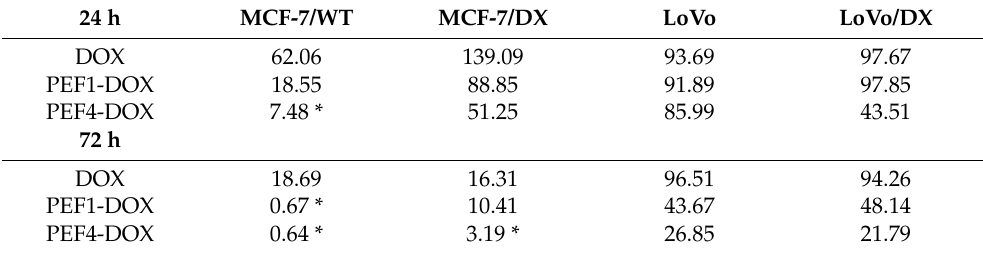
Table 1. IC50 values that reduce cell proliferation by 50% calculated and represented as micromolar concentration for DOX and PEF + DOX exposure after 24 and 72 h. PEF1 and PEF4 (ESOPE) protocols were selected. 24 h MCF-7/WT MCF-7/DX LoVo LoVo/DX DOX 62.06 139.09 93.69 97.67 PEF1-DOX 18.55 88.85 91.89 97.85